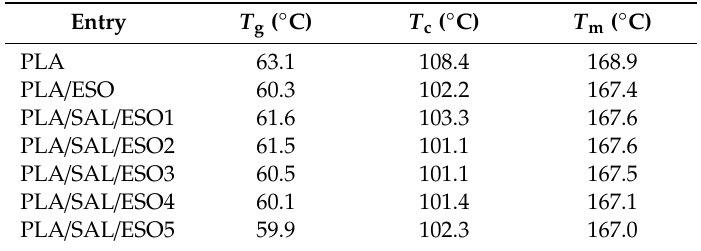
Table 3. The DSC data of PLA, PLA/ESO, and PLA/SAL/ESO composites.